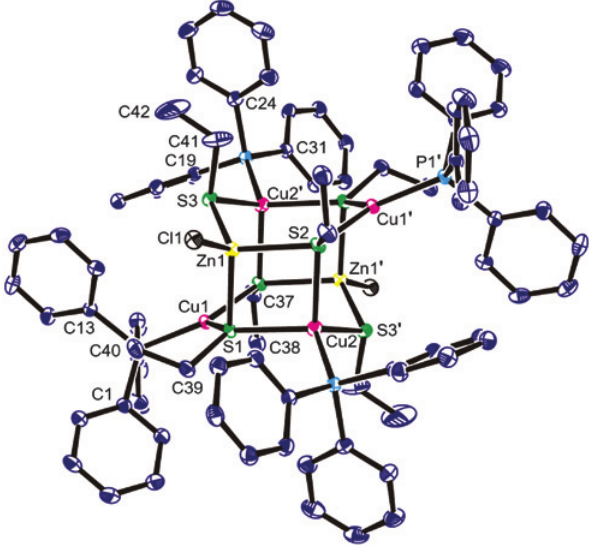
Figure 1: The asymmetric unit of 1 showing the labelling scheme used; thermal ellipsoids are at the 30% probability level.